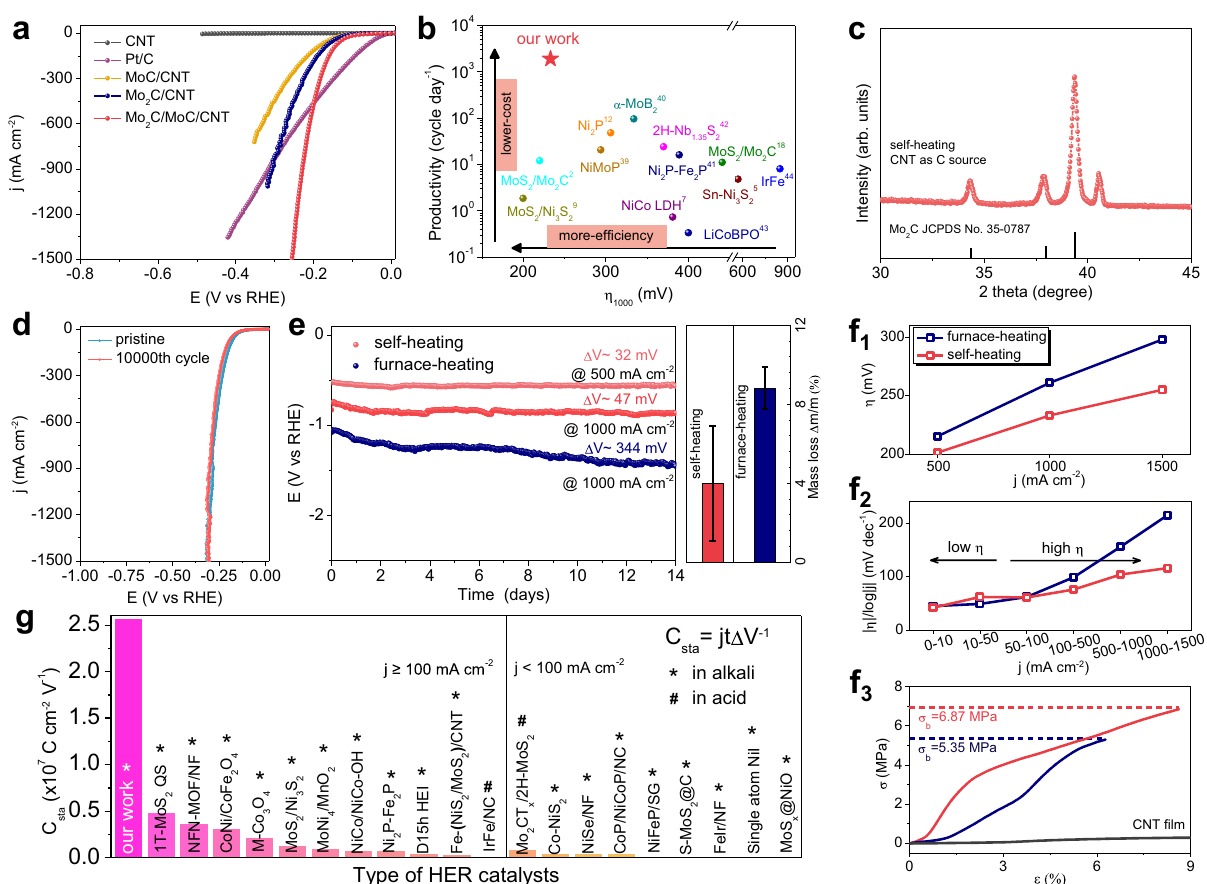
Fig. 4 Electrocatalytic HER performance of Mo 2 C/MoC/CNT fi lms. a Polarization curves of Mo 2 C/MoC/CNT fi lm, Mo 2 C/CNT fi lm, MoC/CNT fi lm, pure CNT fi lm and Pt/C (20wt% of Pt) in 1M KOH. b Comparison of overpotentials at 1000mAcm − 2 versus productivity (synthesis cycles in a day) among